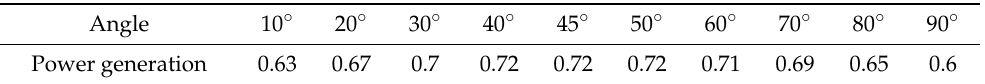
Table 3. Pearson’s correlation coefficient with power generation at various angles. Angle 10 ◦ Power